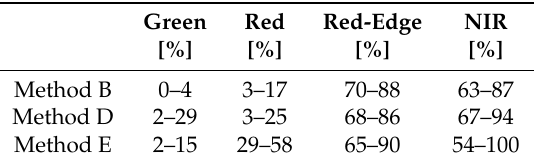
Table 7. Percentage of pixels within the validation range for each multispectral band and radiometric calibration method. Provided range indicated the minimum and maximum percentage values identified across flights.